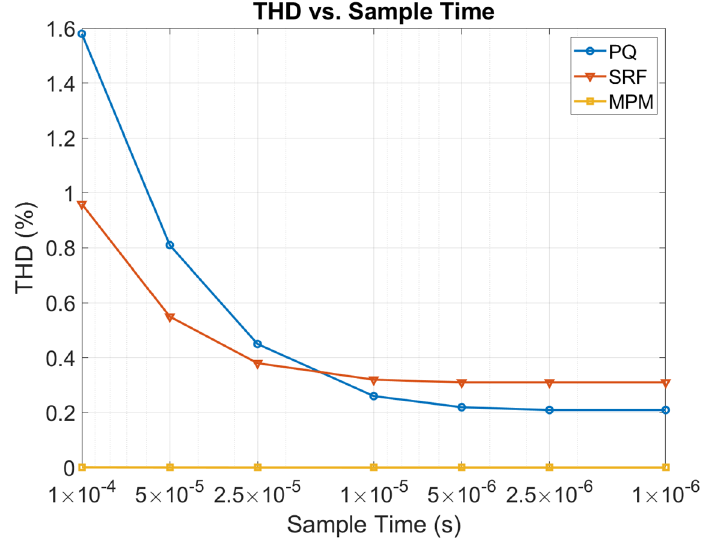
Figure 2. THD vs. Sample time.